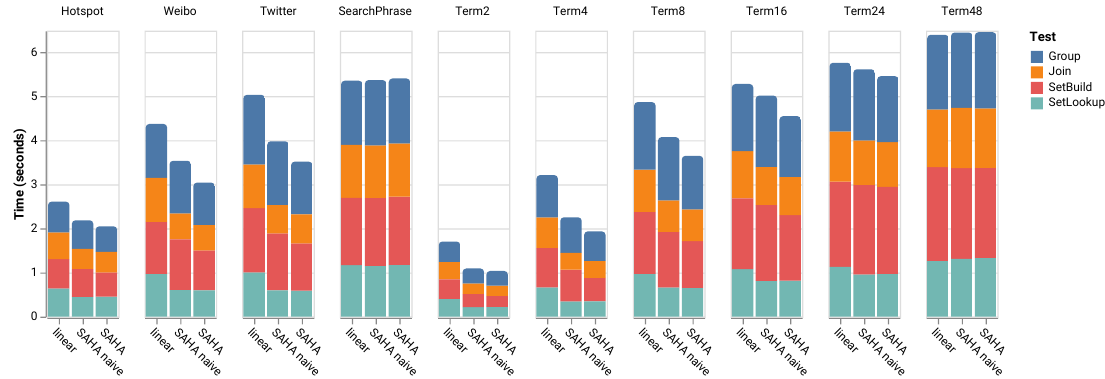
Figure 12. A bar graph of the accumulated runtime of Linear , SAHA with naive dispatching and SAHA for SetBuild, SetLookup, group and join benchmarks on all datasets.